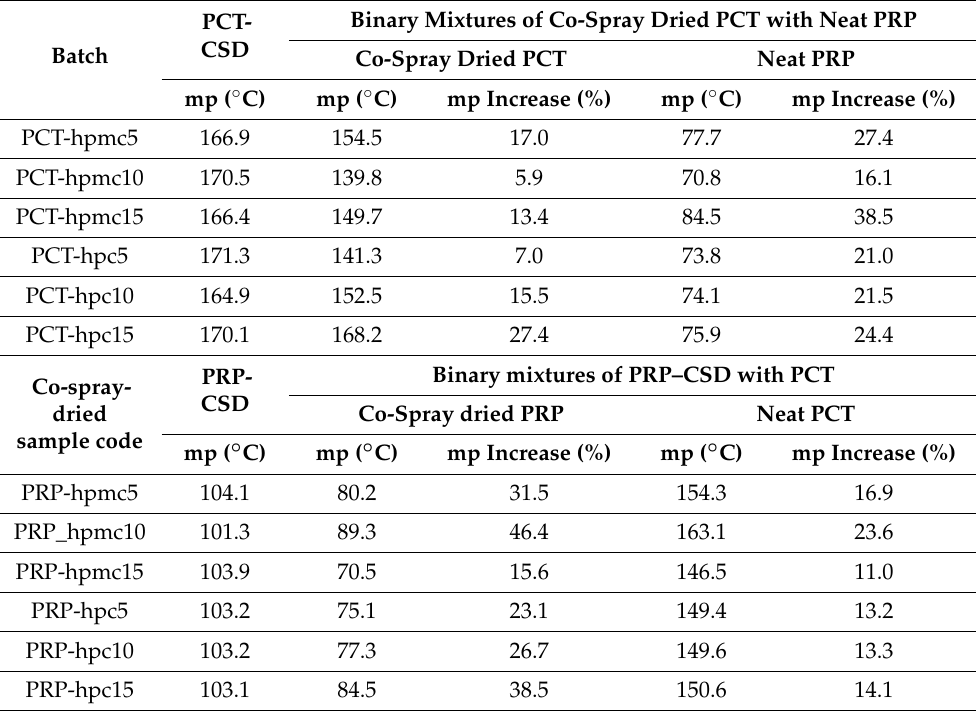
Figure 5. DSC thermograms of binary mixtures of ( a ) co-spray dried PCT/neat PRP, and ( b ) co-spray dried PRP/neat PCT (dotted lines correspond to melting points of the drugs in their physical mixture). Table 2. Melting points (mp) of co-spray dried drugs alone and in co-spray dried/neat binary mixtures together with mp increase due to the presence of polymers relative to physical mixture of the drugs (both in neat